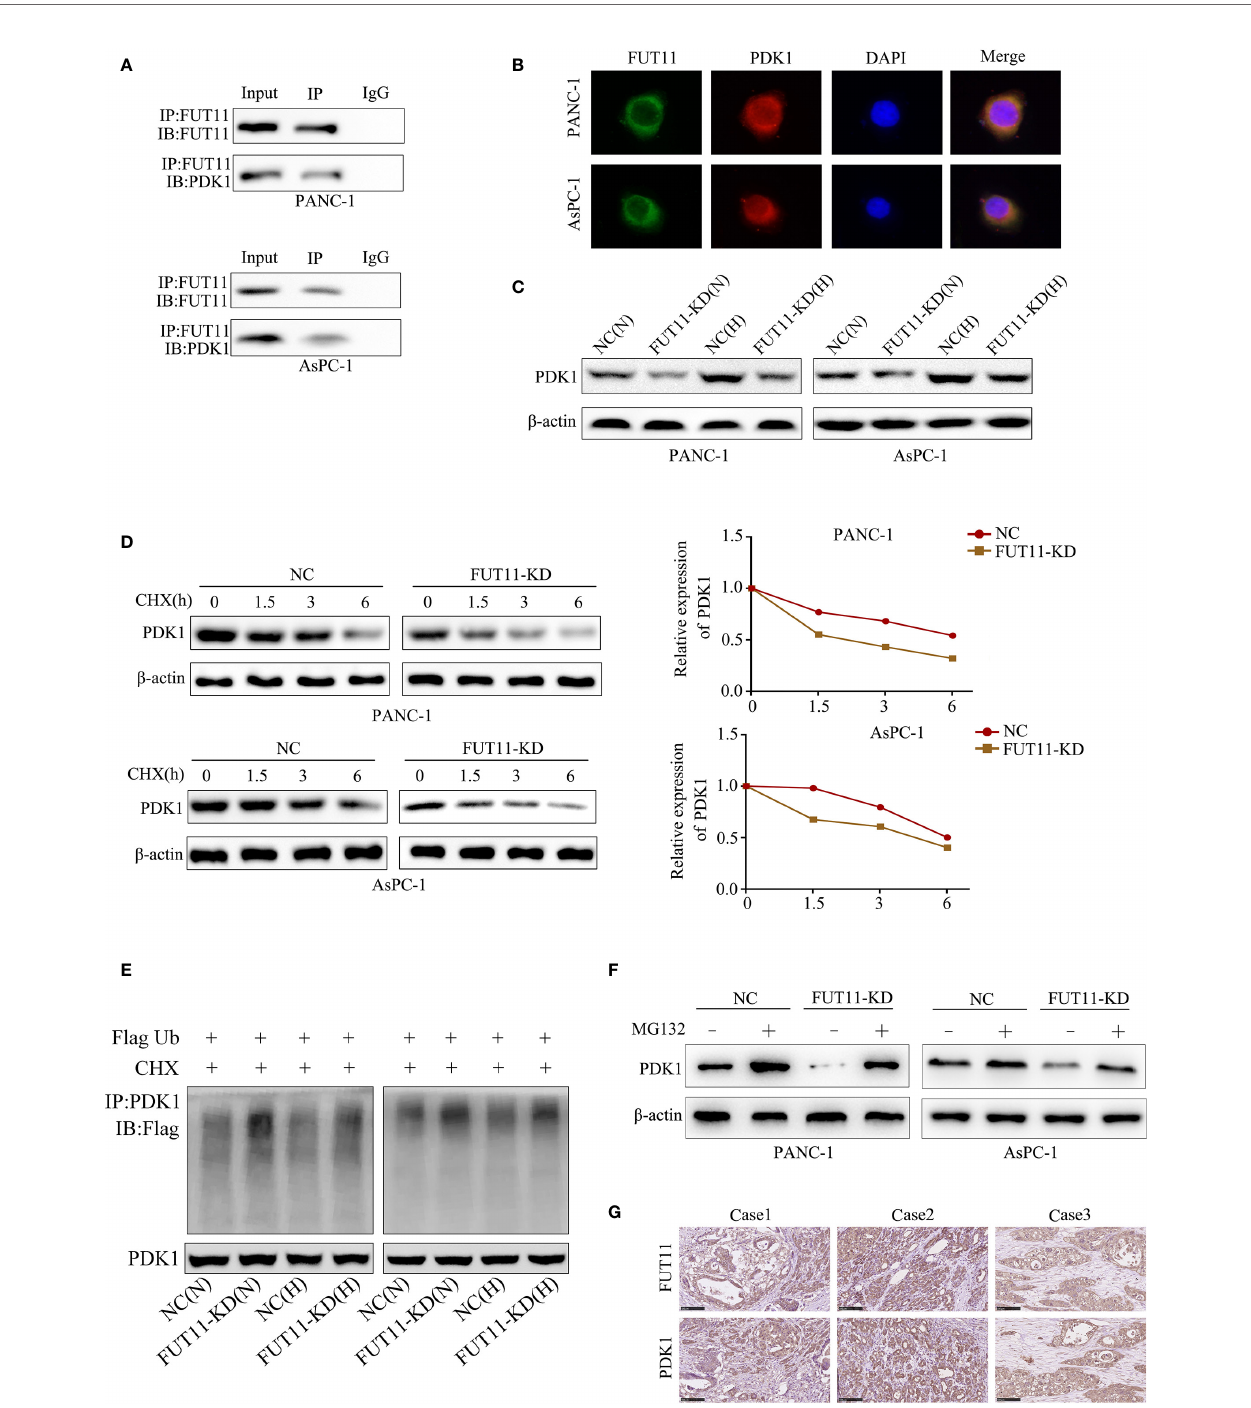
FIGURE 5 | FUT11 bound to PDK1 and regulated its expression. (A) Immunoprecipitation on the binding between FUT11 and PDK1. (B) Immuno fl uorescence showed FUT11 co-localized with PDK1 in PC cells. (C) Western blot on the expression of FUT11 in sh-scramble and FUT11 knockdown PC cells under normoxia and hypoxia. (D) The ubiquitination assay showed the ubiquitination level of PDK1 in sh-scramble and FUT11 knockdown PC cells under normoxia and hypoxia. (E) CHX was used to inhibit the protein synthesis, and the degradation of PDK1 in sh-scramble and FUT11 knockdown cells under hypoxia detected using Western blot. (F) Western blot on the expression of PDK1 in sh-scramble and FUT11 cells treated with MG132 under hypoxia. (G) IHC images showed the co-expression of FUT11 and